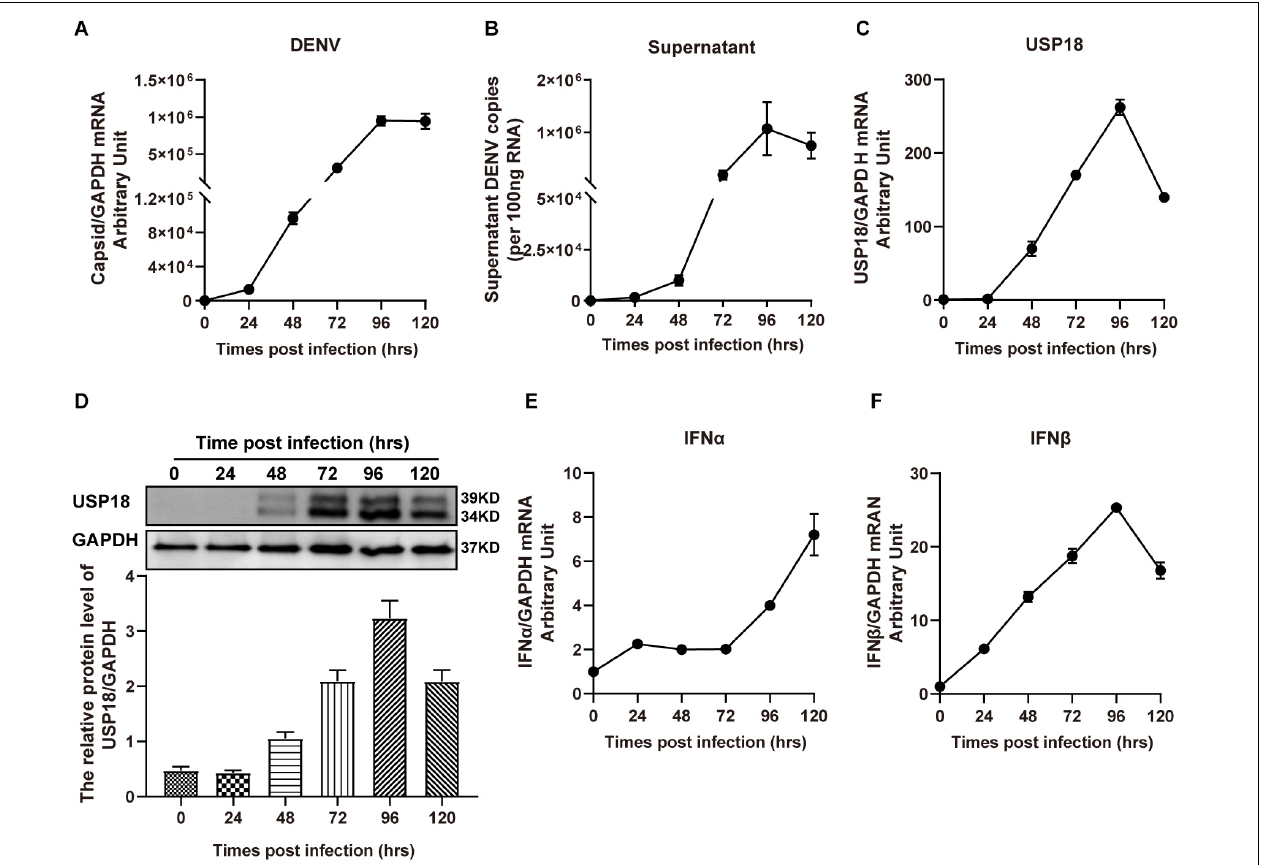
FIGURE 1 | USP18 expression is induced in DENV-2 infected cells. Hela cells and culture medium were collected at various time points post-DENV-2 infection (MOI = 1). Total RNAs were extracted and reverse-transcribed for determining the mRNA levels of DENV-2 RNA (A,B) , USP18 (C) , IFN- α (E) , and IFN- β (F) by real-time PCR. Cell lysates were subjected to Western blot analysis of USP18 expression with GAPDH as a loading control, and data were normalized to GAPDH shown as arbitrary units (fold change) (D) . Data are presented as mean ± SD. Error bars indicate